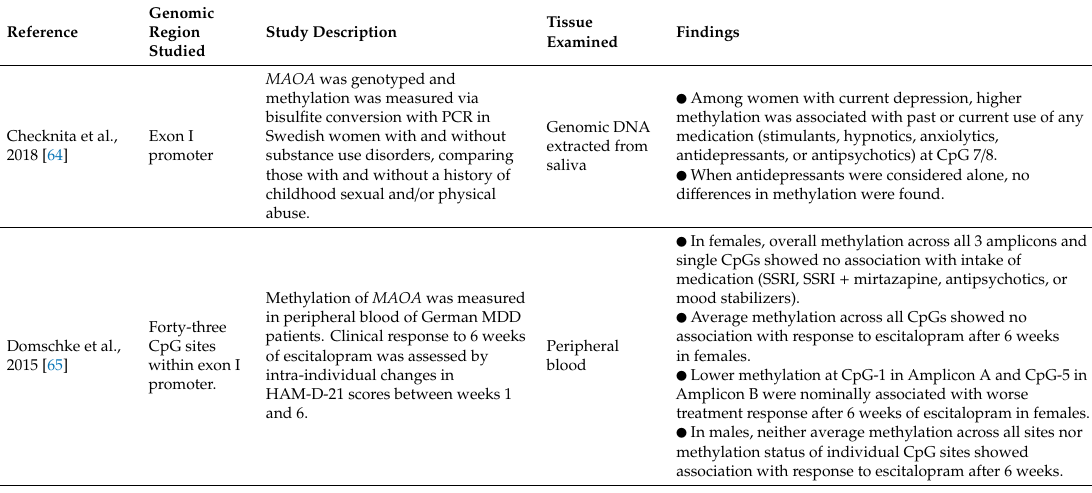
Table 2. Summaries of studies exploring relationship of antidepressants and MAOA DNA